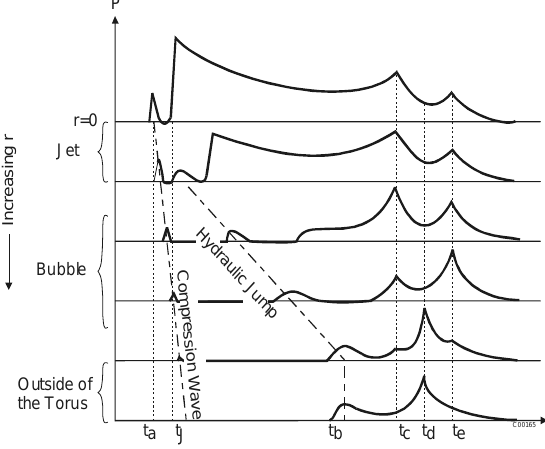
Fig. 4. Schematics of bubble loading on the plate. Times shown are: t a , arrival of the jet at water layer; t J , arrival of jet at solid surface; t b , impact of hydraulic jump on outer edge of bubble; t c , start of jet flow relief from the collapse of bubble fragments; t d , impact of jet flow on outer edge of bubble; t e , the collective minimum volume of the bubble fragments and the beginning of bubble re-expansion. water, leading to a peak pressure of ρcv . Because the jet is of finite width and conical shape, the jet flow is deflected to the side along the plate, and the pressure depends on the amount of relief provided by that flow. The presence of the gas bubble provides a geometric constraint that significantly affects the deflected